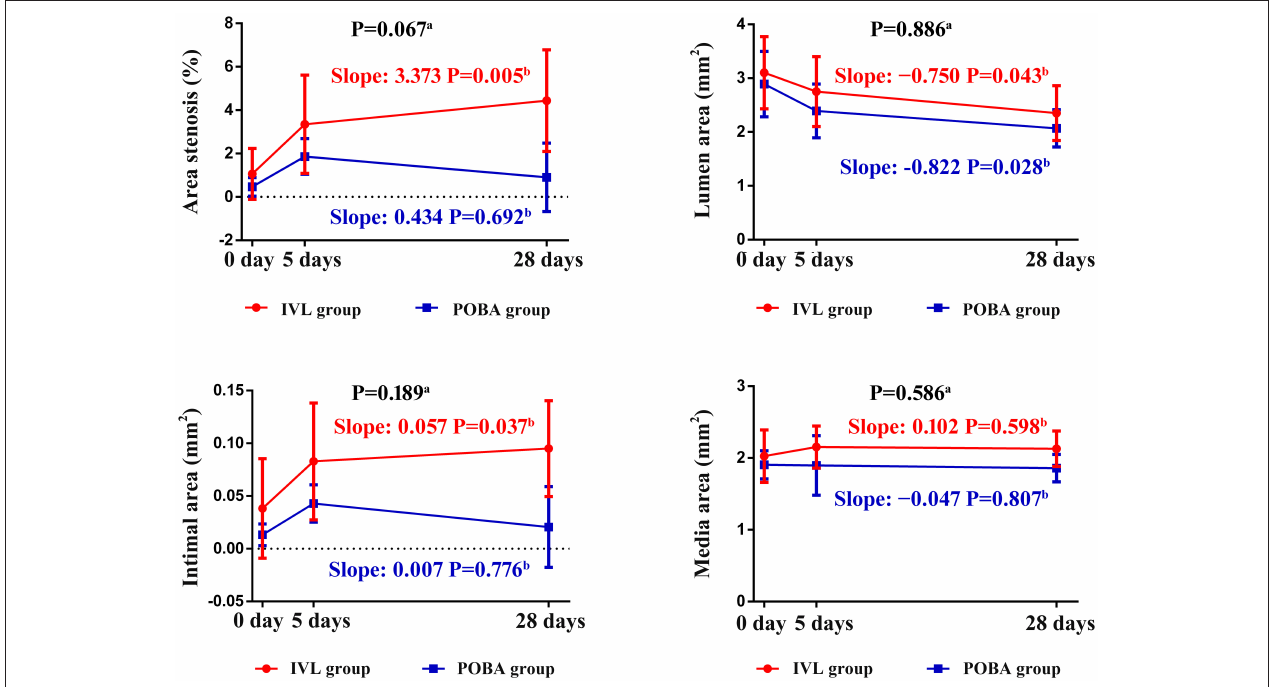
FIGURE 5 | Histomorphometric analyses of treated vessel sections in the IVL and POBA groups. Statistical analysis was performed to compare groups (a) and the change over time (b) from 0 to 28 days using generalized additive mixed models. P < 0.05 indicates statistical significance. IVL, intravascular lithotripsy; POBA, plain old balloon